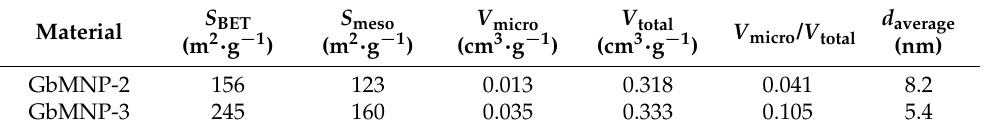
The textural properties of the synthesized materials: specific surface area ( S BET ),